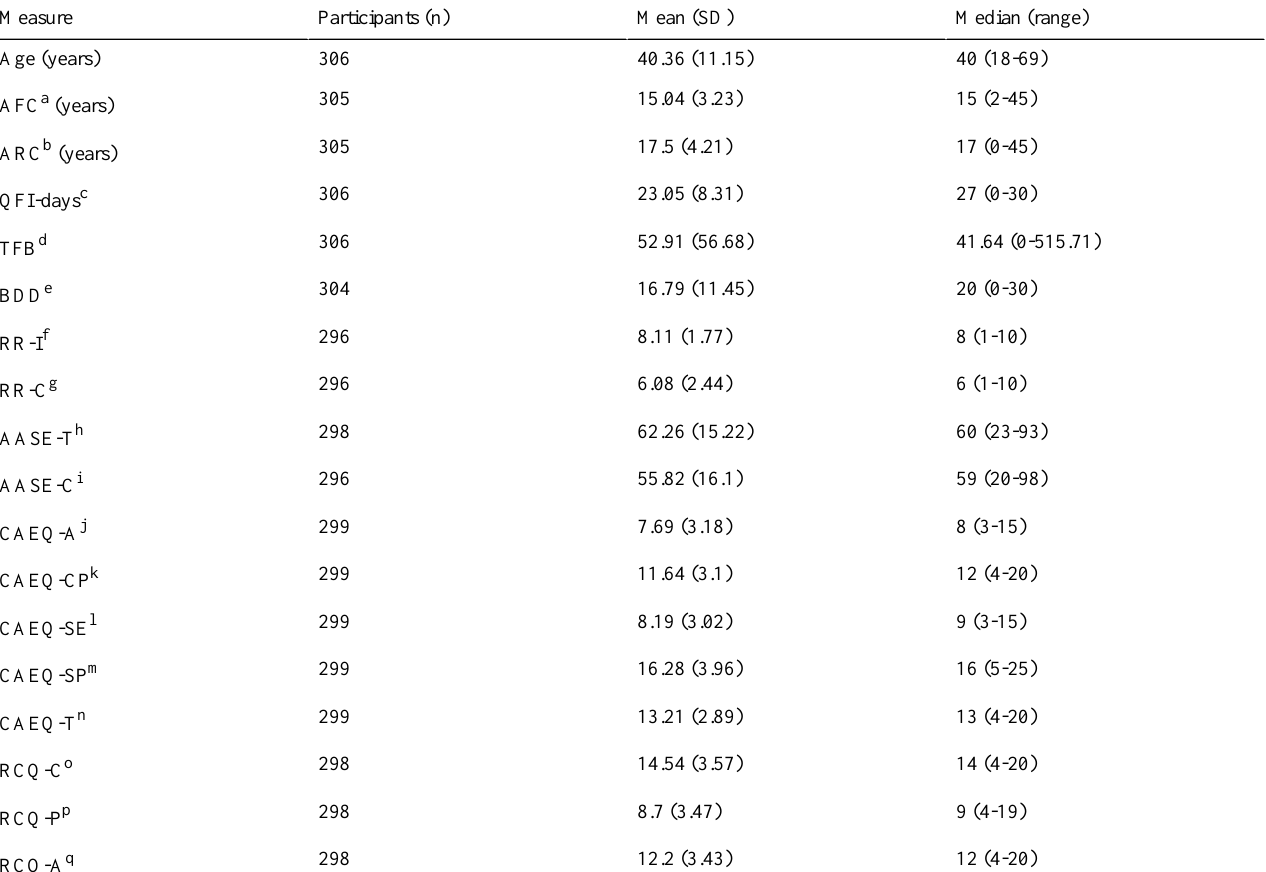
Table 1. Overview of the baseline characteristics of the final